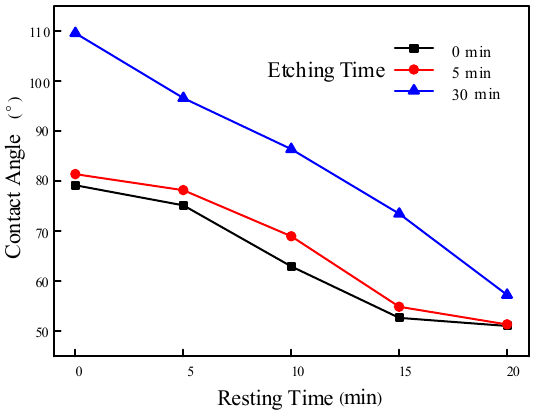
Figure 3. Static contact angle of epoxy resin samples with different etching times.